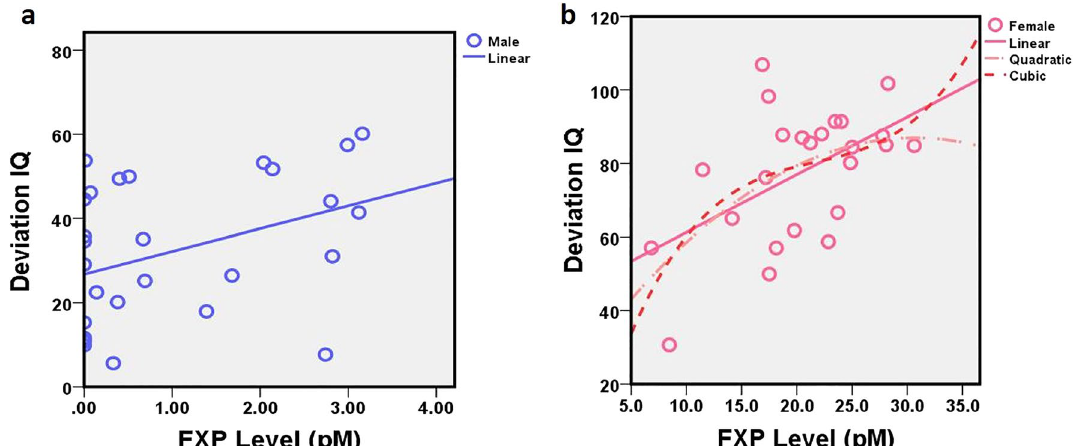
Figure 7. Linear and non-linear correlations between FXP concentrations and Deviation IQ scores for males ( a ) and females ( b ) with FXS. FXP Fragile X Protein, FXS Fragile X